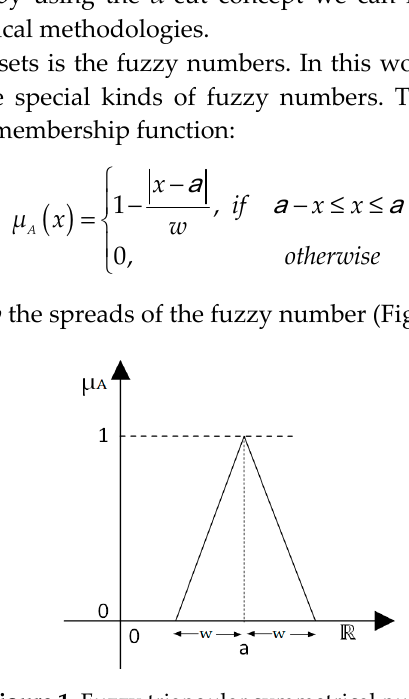
Figure 1. Fuzzy triangular symmetrical